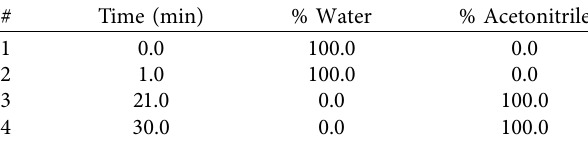
Table 1: Gradient elution of the mobile